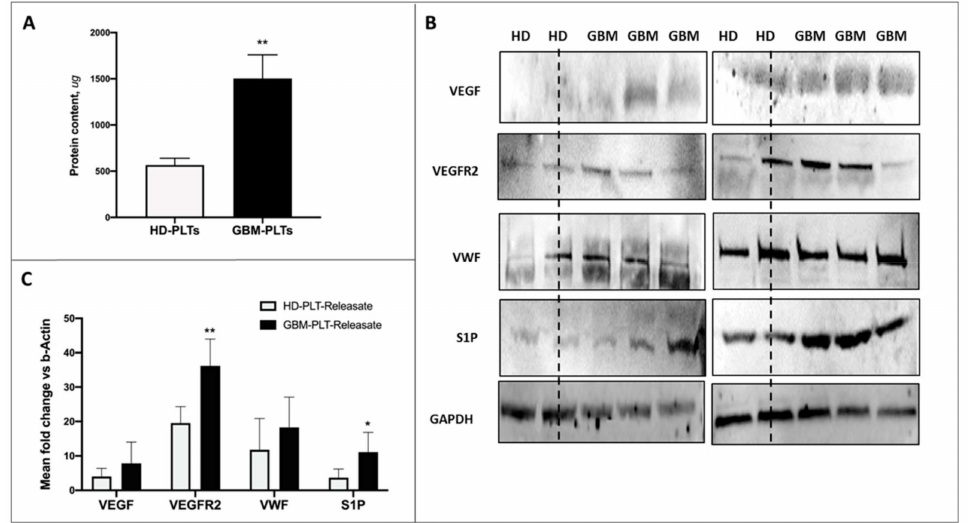
Figure 4. Pro-angiogenic and pro-tumoral protein contents in GBM- and HD-PLTs. ( A ) Quantification of HD- and GBM-PLT protein contents. Data are shown as mean ± SD of all samples analyzed, normalized to the PLT count. ( B ) Densitometric quantification of the protein expressions of VEGF, VEGFR2, VWF, and S1P in all of the analyzed HD- and GBM-PLTs. Data were normalized to GAPDH expression, used as an endogenous control, and reported as the mean ± SD. ( C ) Representative images of Western blot analysis for the assessment of protein concentrations of VEGF, VEGR2, VWF, and S1P in PLT-releasate from 2 HD-PLTs and 4 GBM-PLTs. Notably, the graph in Figure 4C reports densitometric data versus GAPDH. * p < 0.05, ** p < 0.01, *** p < 0.001 versus healthy donors